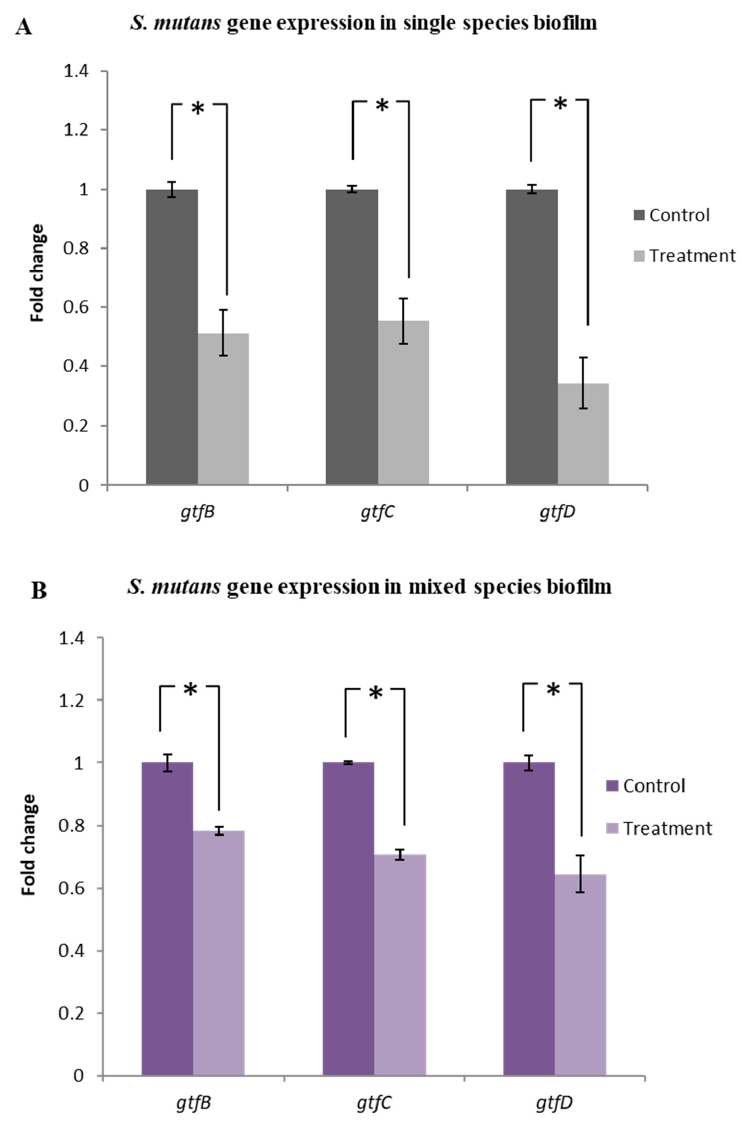
Figure 6. Lactobacillus plantarum 108 supernatant down-regulated the gtf gene expression in Streptococcus mutans single and mixed-species biofilms. Quantitative PCR was performed to evaluate the expression of gtfB, gtfC , and gtfD genes in ( A ) single and ( B ) mixed species biofilms treated with Lp108 supernatant. Target genes in the sample were normalized with the S. mutans housekeeping gene 16sRNA. The graphs show the relative expression fold change of treated group with respect to the control group. Data represent the mean ± SD of three independent experiments and statistical significance (*) with respect to the control group ( p <